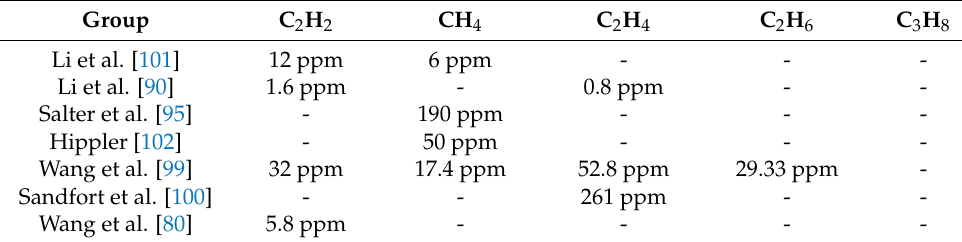
Table 6. Hydrocarbons and their LODs for different CERS setups. Group